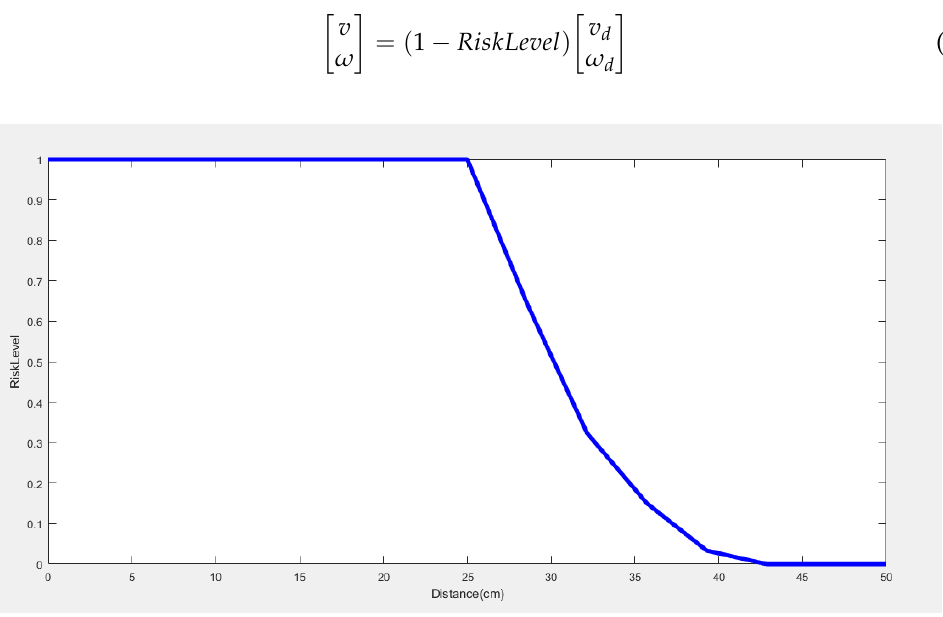
Figure 10. Nonlinear function corresponding to the Fuzzy Collision Risk